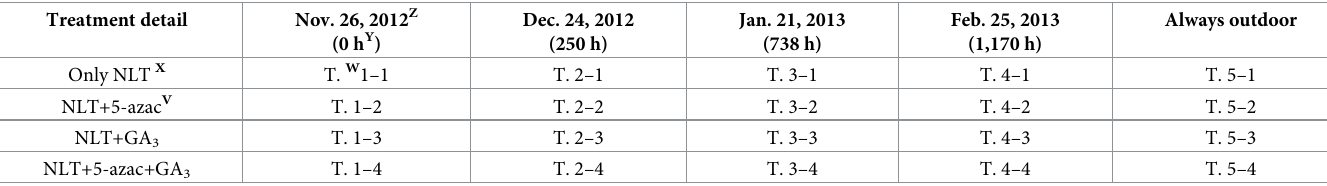
Table 3. Details of 20 treatments for the forcing culture of ‘Hang Baishao’ under naturally low temperature, 5-azacytidine and/or GA 3 . Treatment